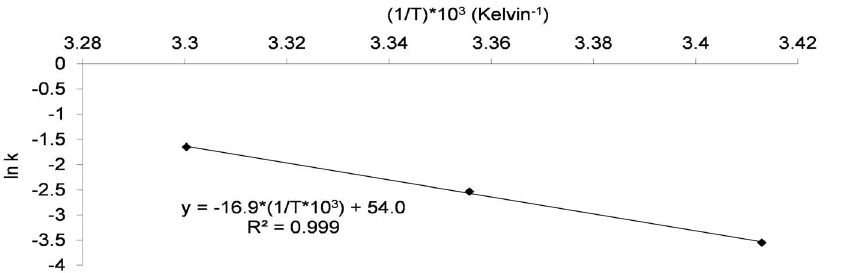
Figure 4. Arrhenius representation for Bacilor H ( Lcrrestituo H capsules). The observed k values were previously obtained with ln(N t /N 0 ) against time for Bacilor H ( Lcr restituo H capsules) (Fig. 3). These k values (y axis) were represented against 1/T (Kelvin 2 1 ) (x axis) to obtain the Arrhenius equation of this assay (Equation 5).